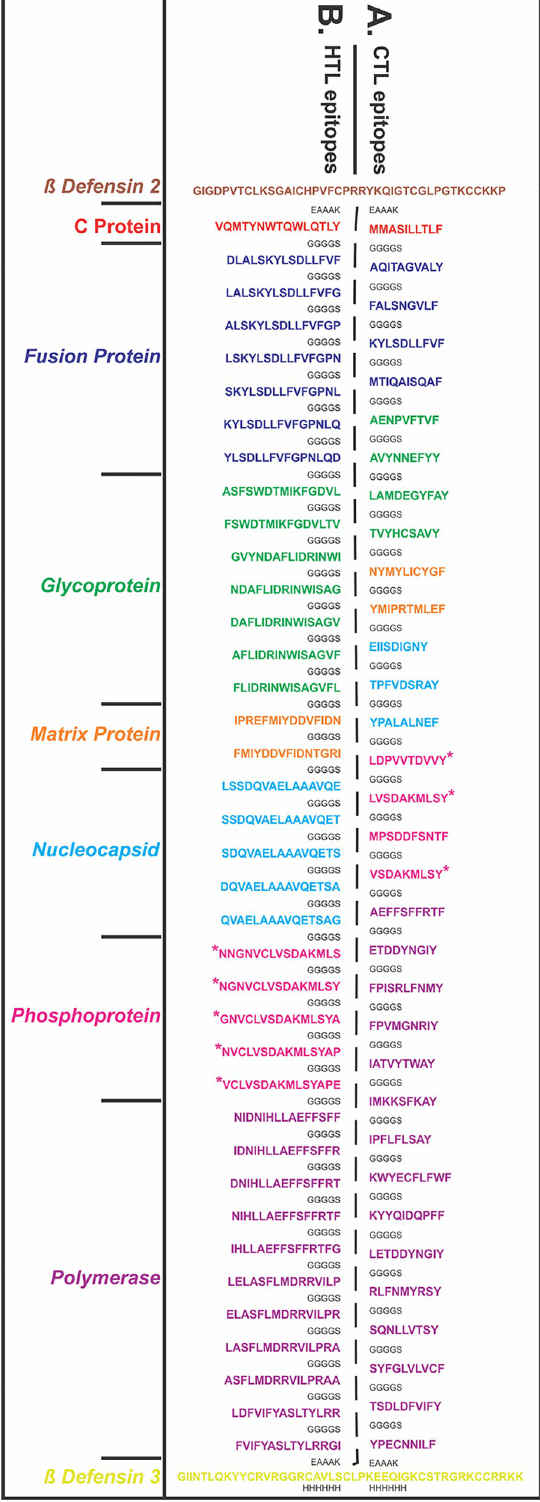
Fig 5. Design of Multi-Epitope Vaccine (MEVs). (A) CTL and (B) HTL epitopes were linked by the short peptide linker ‘GGGGS’. Human Beta-Defensin 2 and Beta-Defensin 3 were used as an adjuvant at the N and C